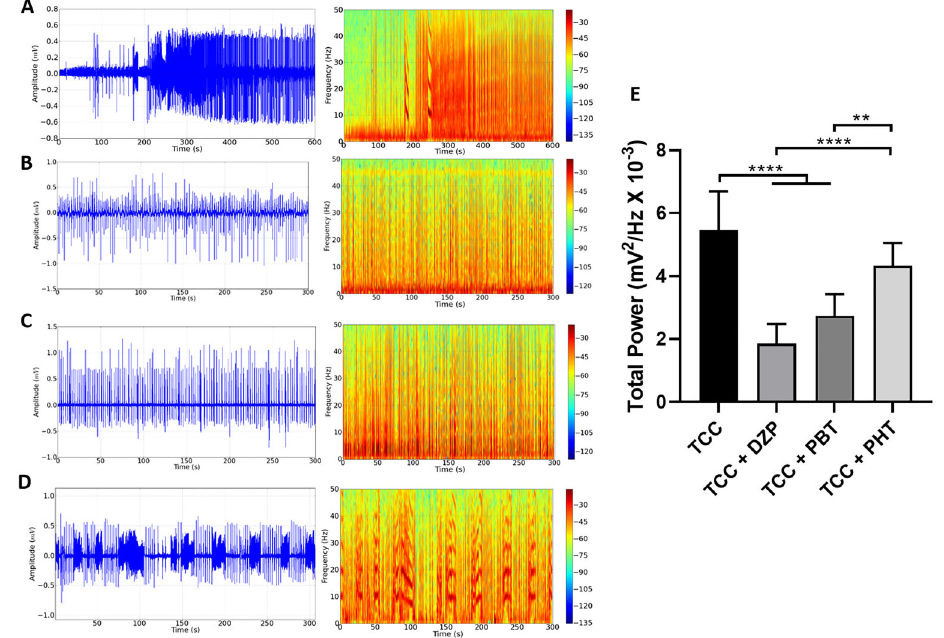
Figure 3. Representation of the total spectral power distribution of ( A ) thiocolchicoside (TCC) group, ( B ) diazepam (DZP) group, ( C ) phenobarbital (PBT) group, ( D ) phenytoin (PHT) group. E , Representation of the total power linear distribution of cerebral activity in the groups. Data are reported as means ± SD (n=7 animals/group). **P o 0.01 and ****P o 0.0001, (one-way ANOVA followed by Tukey ’ s test).